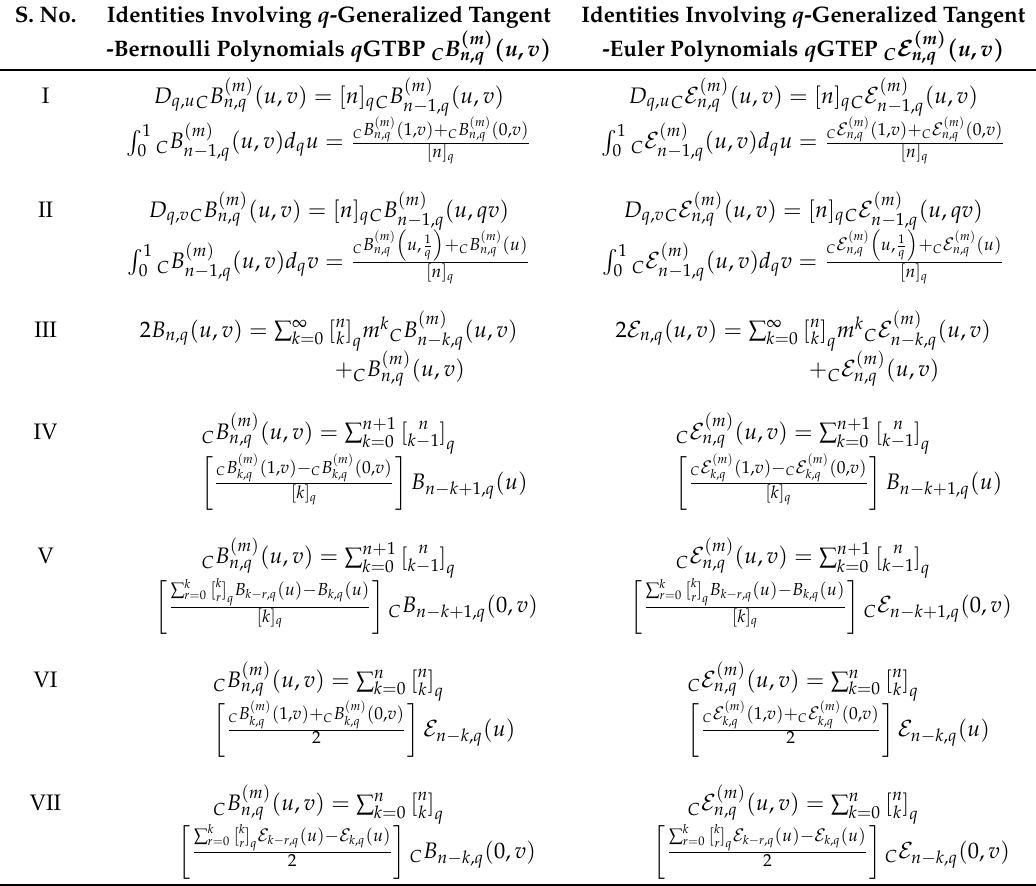
( m ) ( u , v ) and q GTEP n , q